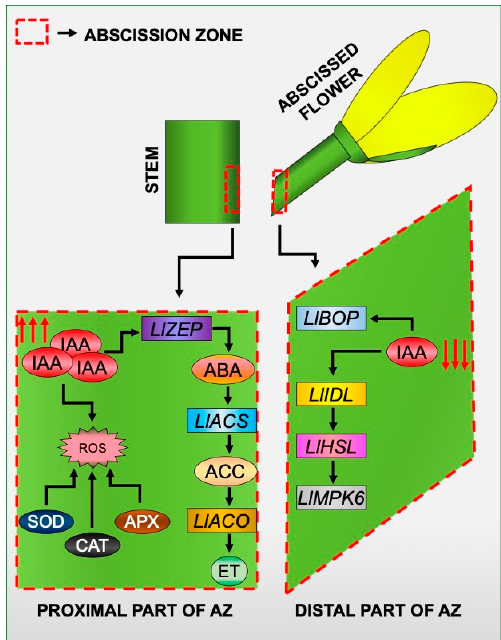
Figure 9. A proposed model for the specific action of molecular markers, phytohormones, and reactive oxygen species (ROS) in different areas of a flower AZ in response to the inhibition of polar auxin transport. Details are given in the text.